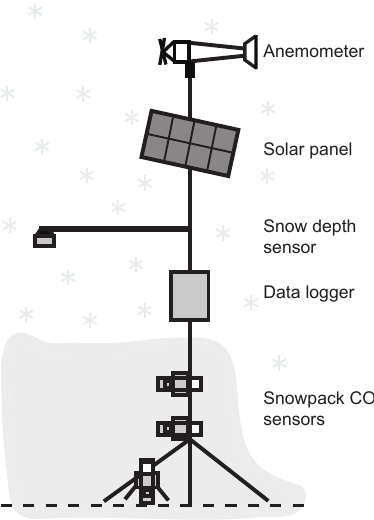
Figure 1. Schematic of initial (2014) CO 2 monitoring stations (NM1, NM2) at North Mountain, Cape Breton. Snowpack CO 2 sen- sors were at 0, 50, and 125cm within the snowpack (diagram not to